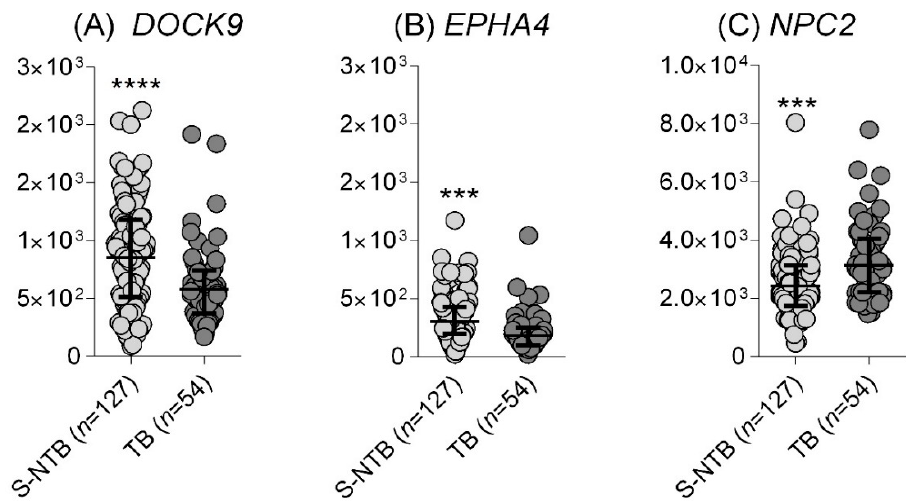
Figure 2. Individual normalized expression values of ( A ) DOCK9 , ( B ) EPHA4, and ( C ) NPC2 mRNA in blood in a South African cohort (E-MTAB-8290). The diagnostic groups comprise adults with respiratory symptoms self-presenting for investigation of pulmonary TB who were ultimately diag- nosed as having TB or not. S-NTB: symptomatic adults showing no laboratorial evidence of active TB disease, regardless of the history of known exposure to a TB index case. TB = active tuberculosis. The Mann–Whitney test was used to assess significance between two groups: *** p -value < 0.005, **** p -value < 0.001.